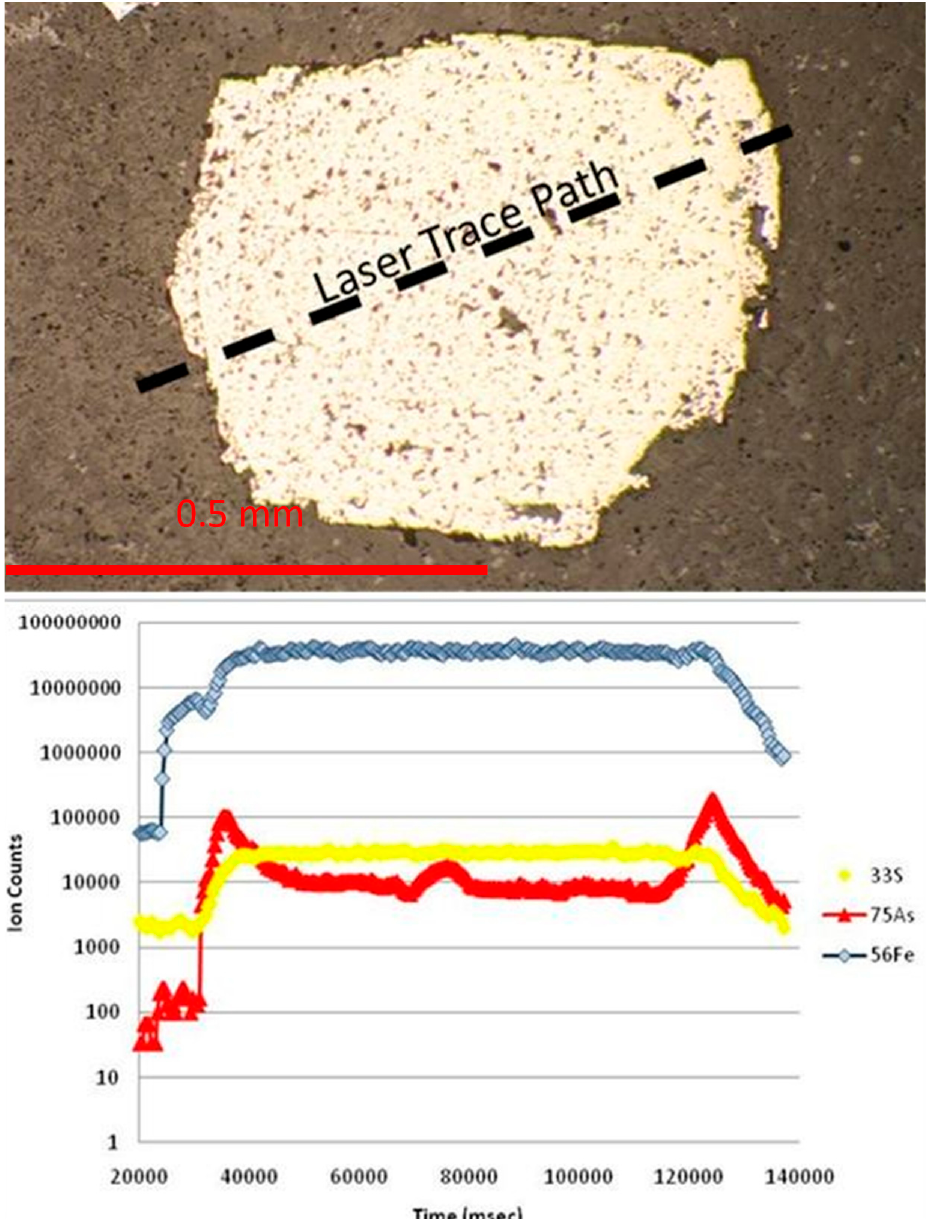
Figure 6. Image showing a pyrite grain and a proposed laser trace. After the trace is performed the graph below shows how the concentrations of key elements vary with time. As can be seen as sulfur and iron values rise (i.e., as you enter the pyrite grain) there is a sharp rise in arsenic values.